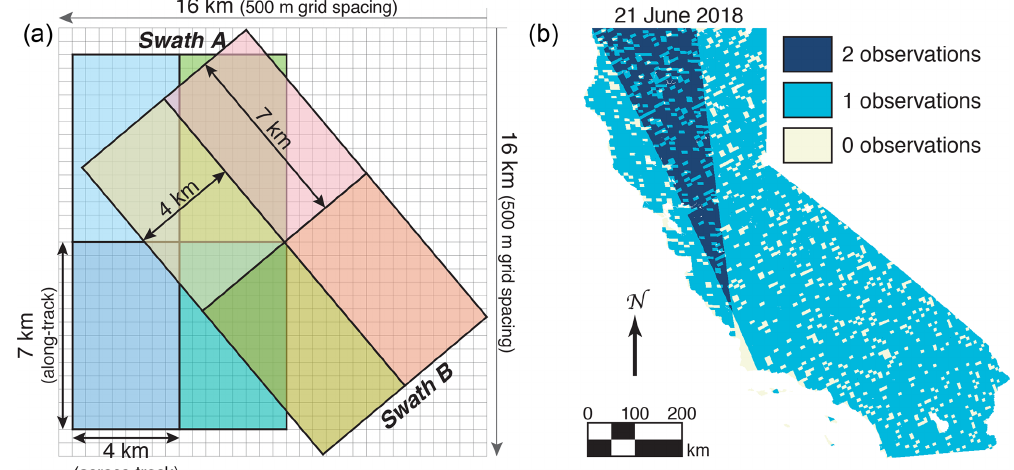
Figure 3. Oversampling schematic. Panel (a) shows the schematic for our oversampling. Gray grid has a grid spacing of 500m (equivalent to the spatial resolution of the MODIS MCD43A4 product). TROPOMI ground pixels are 7km along track and vary from 3.5km (at nadir) to 15km the across track. Schematic shows the spatial extent of eight hypothetical TROPOMI scenes from two swaths at 7 × 4km 2 ; individual TROPOMI scenes are a different color. Swath B is rotated 40 ◦ relative to swath A, resulting in overlapping pixels. Panel (b) shows the number of successful retrievals on 21 June 2018 over California plotted on a 500m